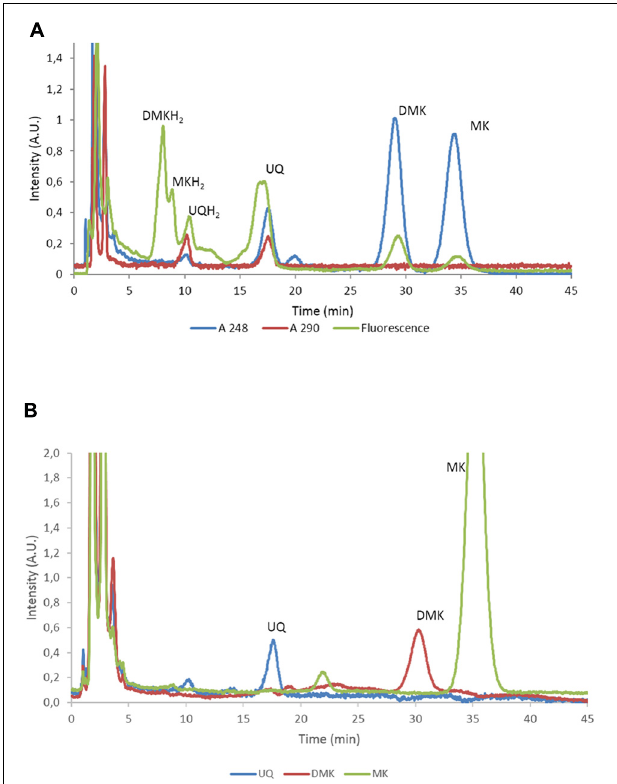
FIGURE 2 | Separation and quantification of the main quinone types of E. coli . (A) High-performance liquid chromatography (HPLC) trace of E. coli MG1655 with the eluate analyzed with A 248 , A 290 and fluorescence. The identified quinones are indicated. UQ, ubiquinone; DMK, demethylmenaquinone; MK, menaquinone. Note that UQ is not fluorescent at these wavelengths and that the peak in the fluorescence channel at approximately 17 min. does not correspond to UQ. (B) HPLC traces recorded at 248 nm of E. coli strains AV34, DMK-only (AV36), MK-only (i.e., E. coli (cid:49) ubiCA complemented with menH from Bacillus subtilis . UQ, ubiquinone; DMK, demethylmenaquinone; MK, menaquinone.